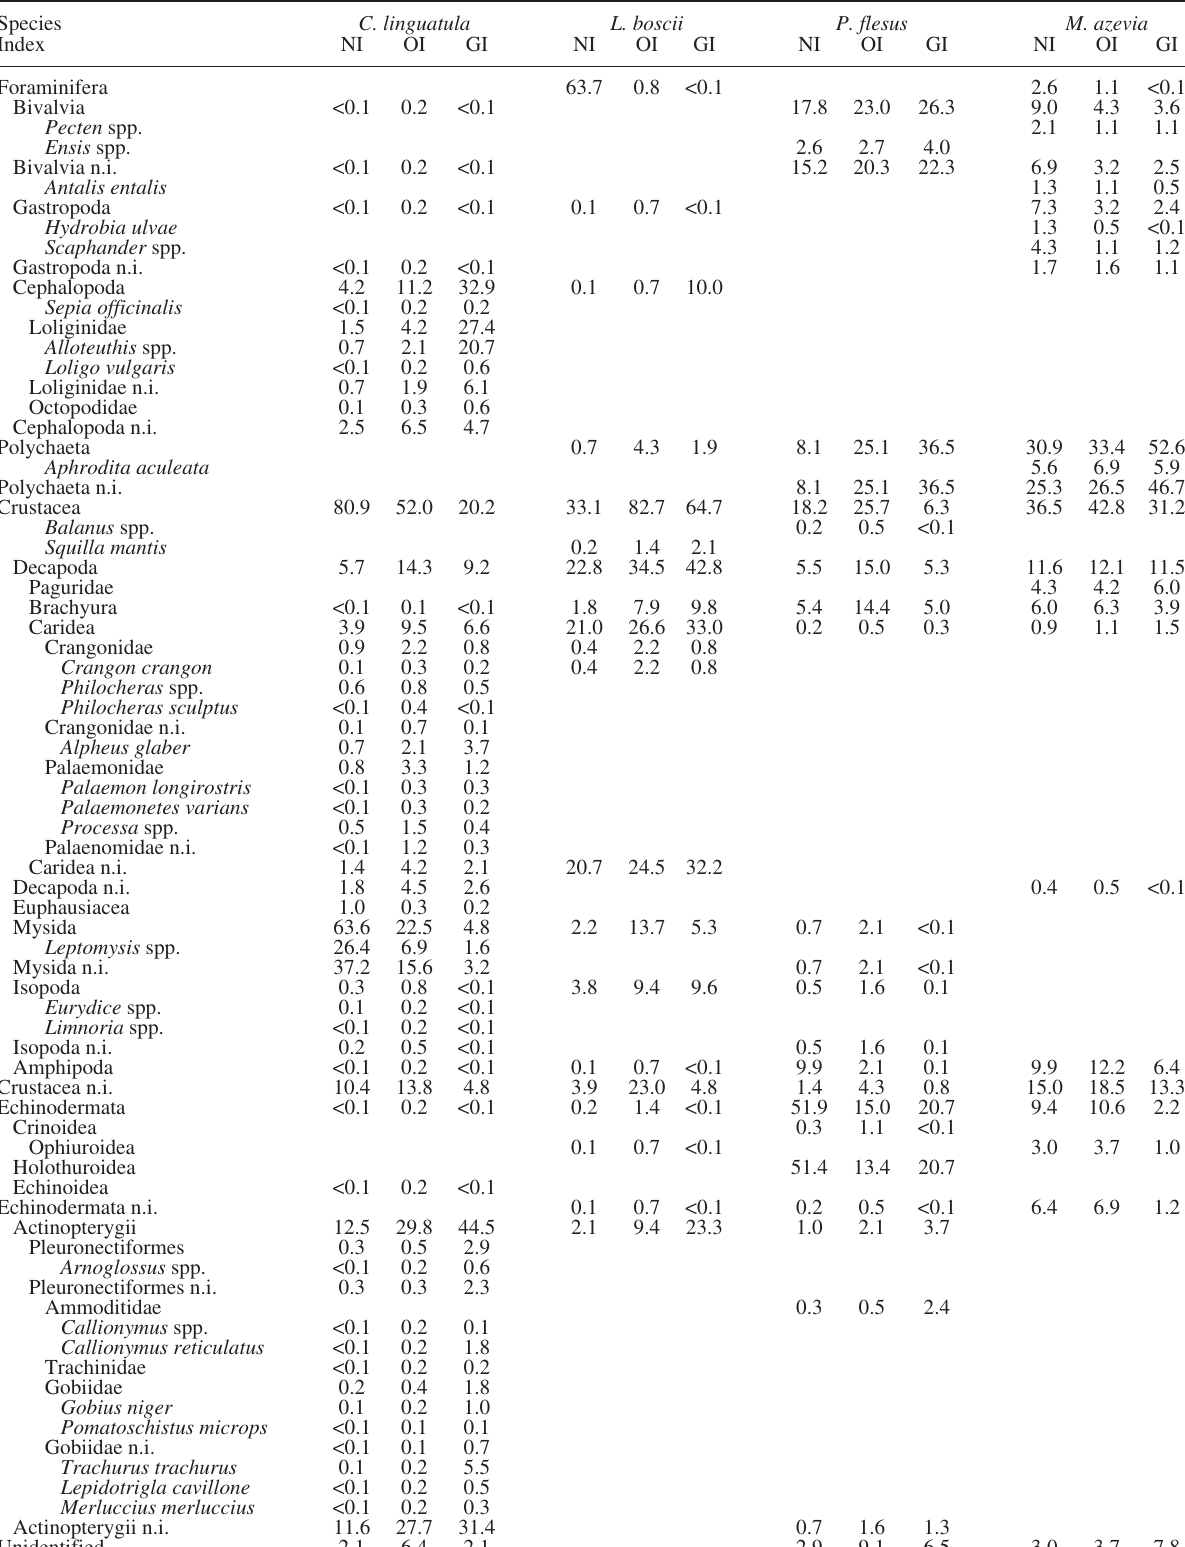
Table 1. – Numerical (NI), occurrence (OI) and gravimetric (GI) index values of prey items identified in stomachs of C. linguatula , L. boscii , P. flesus and M. azevia off the Portuguese coast. Species C. linguatula